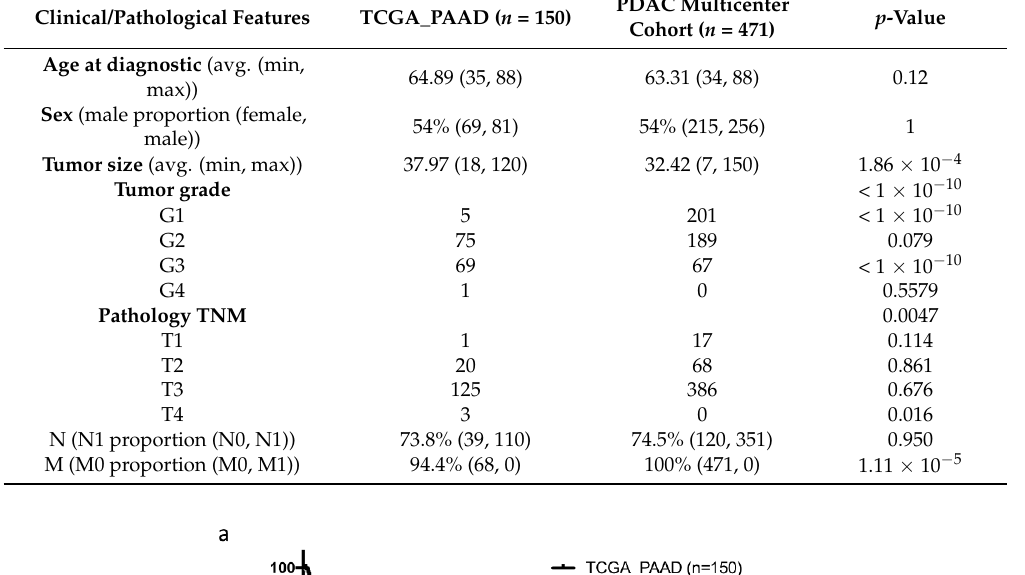
Table 1. Clinical comparison of the TCGA_PAAD and the pancreatic adenocarcinoma multicenter cohort.